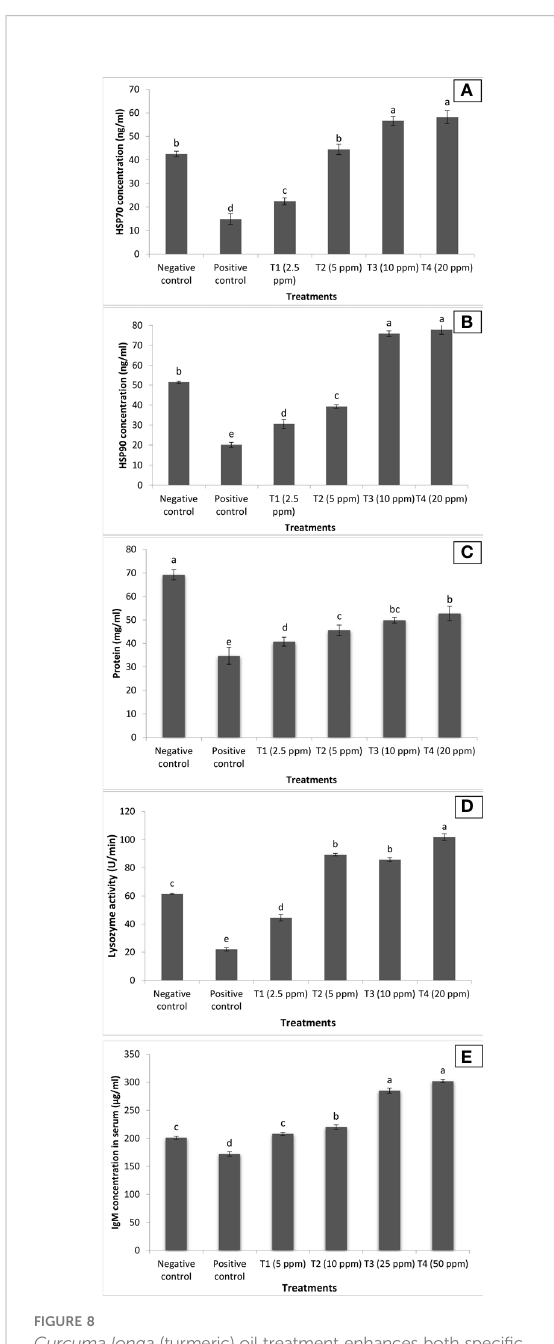
FIGURE 8 Curcuma longa (turmeric) oil treatment enhances both speci fi c and non-speci fi c immune response of Pangasianodon hypophthalmus fi ngerlings against I. multi fi liis and A. hydrophila co-infection. The serum samples of P. hypophthalmus fi ngerlings were collected from six treatment groups. The fi ngerlings in T1 – T4 groups were treated with oil extract at the indicated doses. Non-pretreated larvae that were either co-infected (positive control) or not (negative control) served as controls. (A) HSP70 concentration (ng/ml); (B) HSP90 concentration (ng/ml); (C) protein level (mg/ml); (D) lysozyme activity (U/min); and (E) IgM concentration ( m g/ml). Error bars represent the standard error of fi ve replicates; different letters indicate signi fi cant differences between treatment groups ( p < 0.001).